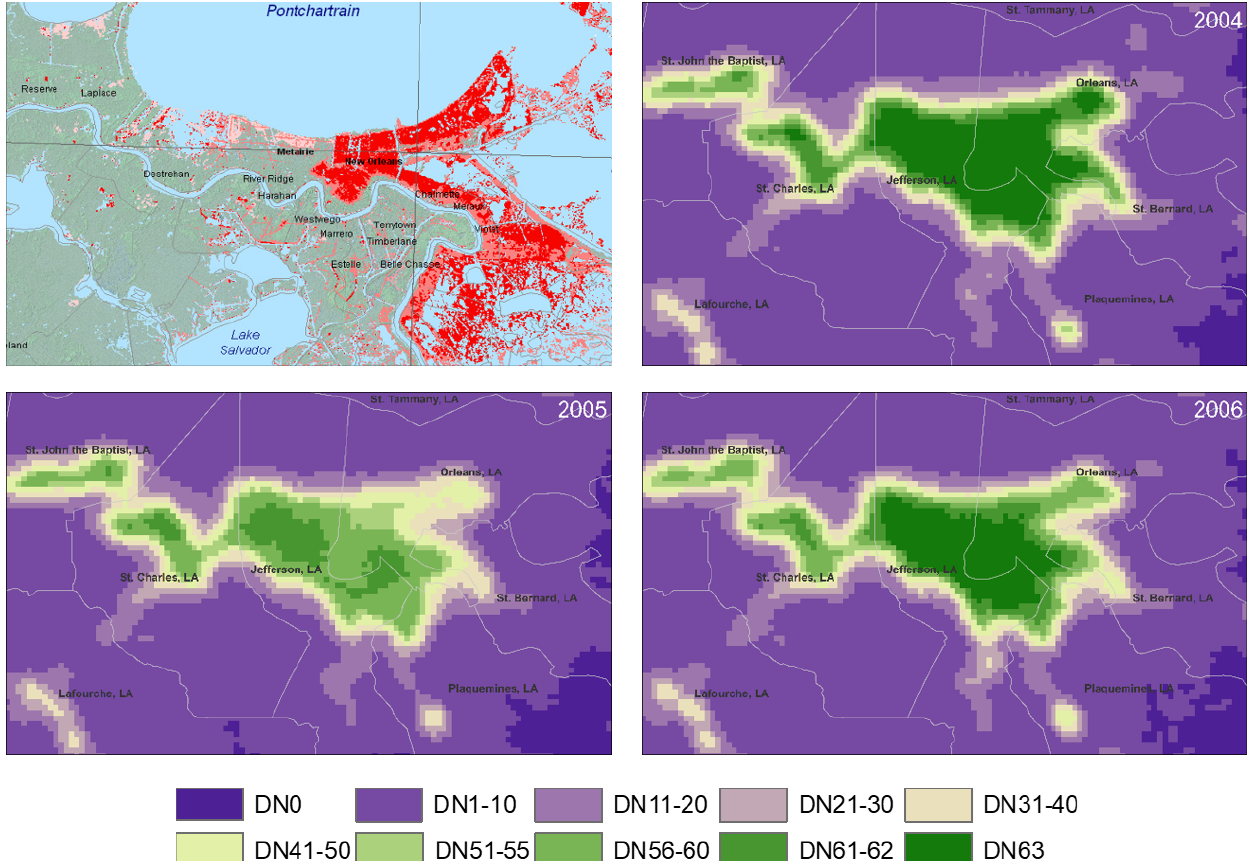
Figure 1. Flooding and night lights for the city of New Orleans before and after Katrina. Top left: excerpt from Dartmouth Flood Observatory flood map of New Orleans (image by Dartmouth Flood Observatory, 2005, reprinted with permission). Color coding indicates flooding by 30 August, 2 September, and 7 September from light to darker shades of red respectively. Note how especially in the eastern part of the city entire neighborhoods were still inundated a week after the hurricane. Knabb et al. (2005) report that the final waters were only cleared 5 weeks later. Top-right and bottom panels: night lights as observed from space by DMSP-OLS (raw uncorrected data from satellite F15). Brighter areas are indicated by green, whereas purple implies darker areas. Much of the city was at maximum brightness of DN63 in 2004 (top right) but fell below this threshold in the year 2005 (bottom left). In line with the pattern of flooding, especially the eastern part of the city dimmed and had only partly recovered by 2006 (bottom right). As discussed, it took almost a decade to recover light levels to their prior intensities in these